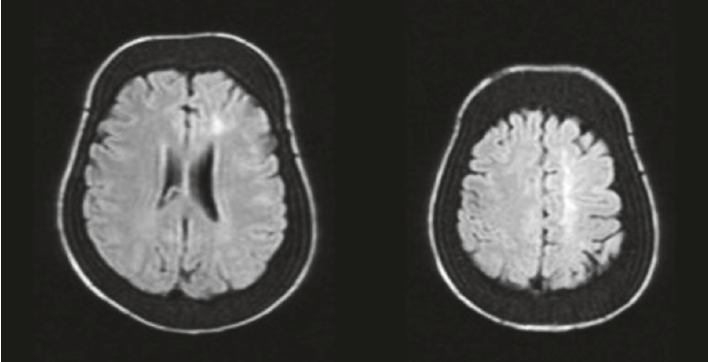
Figure 1: Magnetic resonance imaging in patient with thalassemia major showed flair signal intensity abnormalities in left watershed area and diploe space expansion.